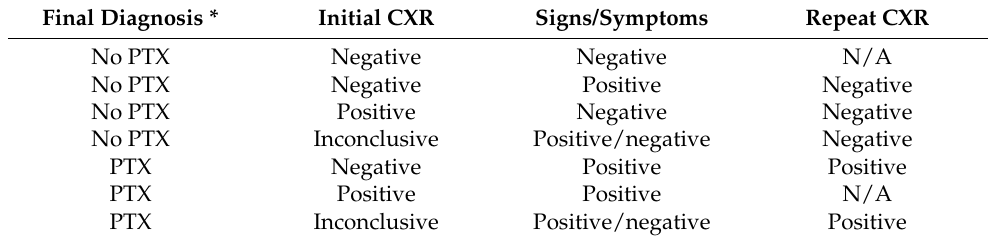
Table 1. Final diagnosis of pneumothorax (reference